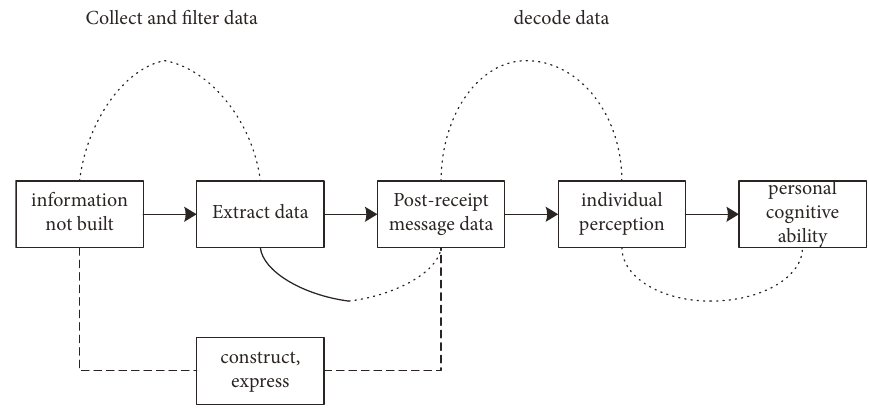
Figure 1: Visual flat design